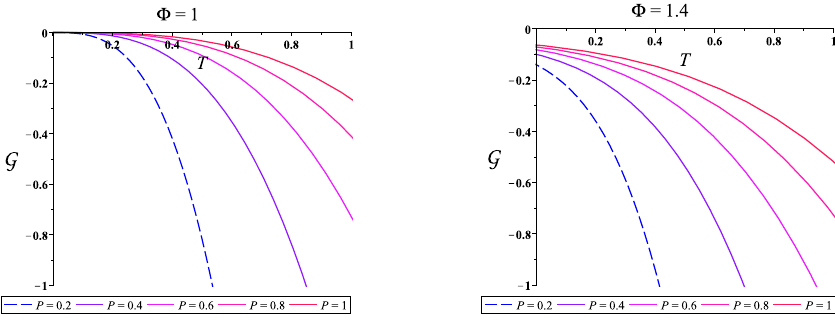
Figure 3 . Thermodynamic potential vs temperature, for (cid:8) (cid:21) 1. In this interval, there is no Hawking-Page phase transition. The extremal limit, T = 0, is reached at a (cid:12)nite entropy. 2 ) ( @ 2 P =@v 2 ) = 2 P (cid:0) 2(1 (cid:0) (cid:8) T; (cid:8) v 2 (cid:25)v